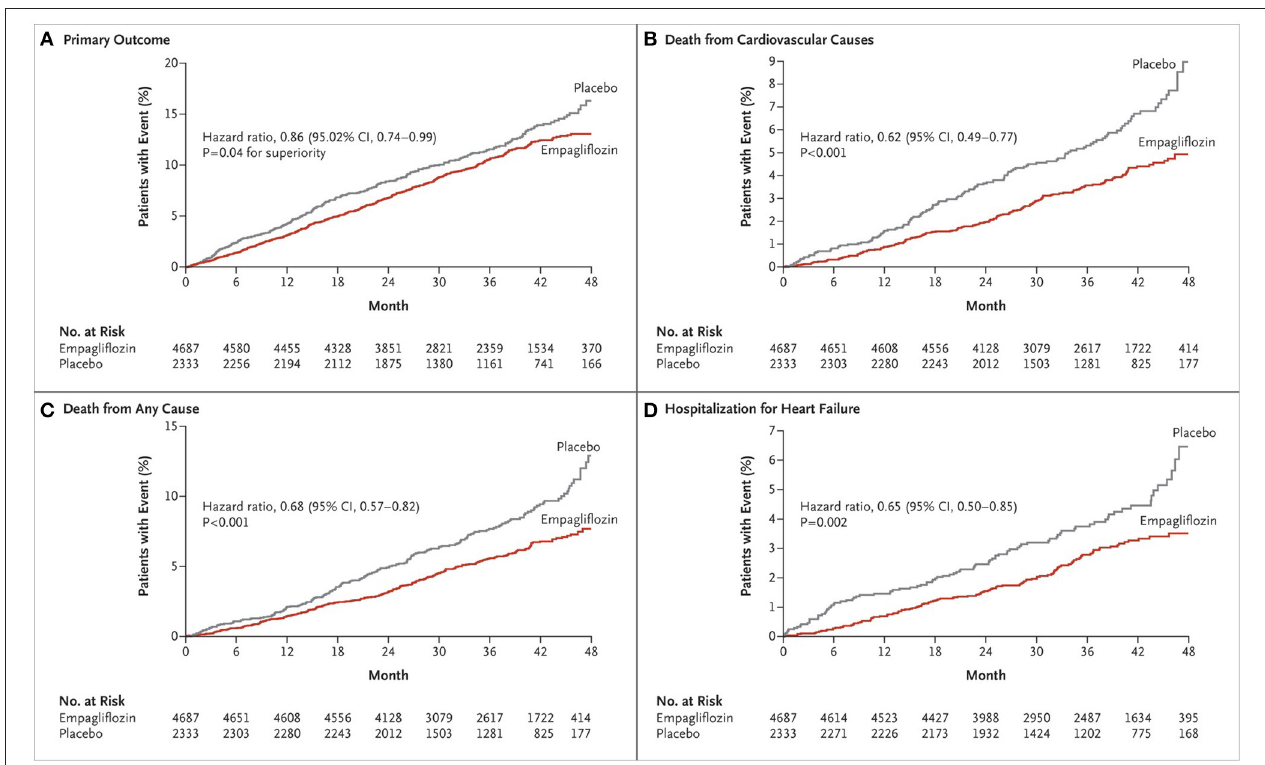
FIGURE 1 | Cardiovascular outcomes and death from any cause in EMPA-REG OUTCOME (16). Cumulative incidence of the primary outcome (death from cardiovascular causes, nonfatal myocardial infarction, or nonfatal stroke) (A) ; Cumulative incidence of death from cardiovascular causes (B) ; Kaplan-Meier estimate for death from any cause (C) ; Cumulative incidence of hospitalization for heart failure (D) . Copyright 2015. Massachusetts Medical Society. Reprinted with permission from Massachusetts Medical